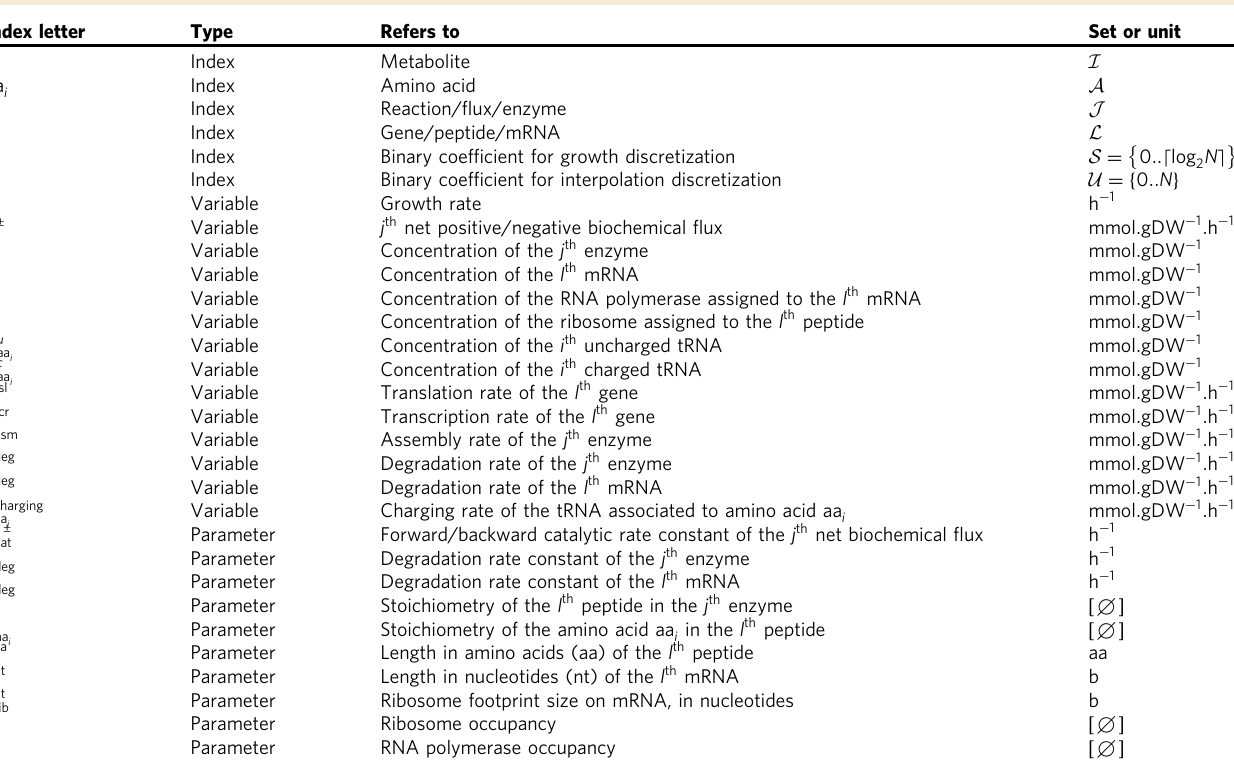
Table 1 Indices, variables, and parameters used in the formulation.